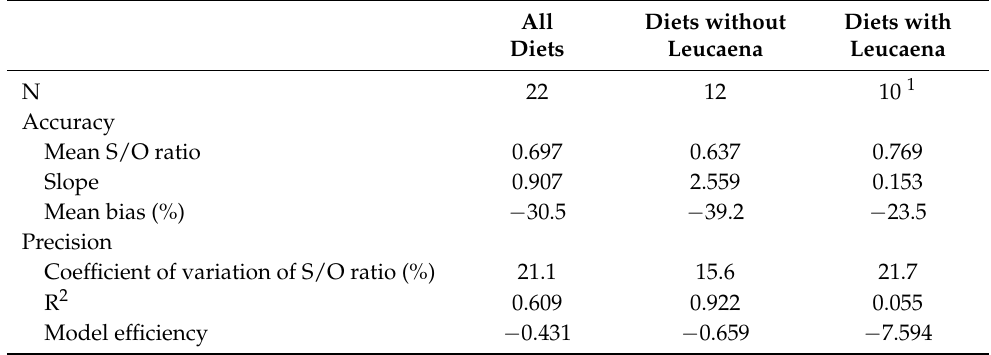
Figure 2. Relationship between the simulated and observed methane emissions for ( A ) all diets; ( B ) diets without Leucaena: ◇ Toledo grass, ◻ = Cayman grass, and ◯ = Star grass plus kudzu (70:30); and ( C ) diets with Leucaena: ◼ = Cayman grass plus L. diversifolia (70:30), ▩ = Cayman grass plus L. leucocephala (70:30), and ◆ = Toledo grass plus Canavalia plus L. diversifolia (70:15:15). Table 4. Descriptors of accuracy and precision of the RUMINANT model in simulating methane emissions for diets of tropical forages.